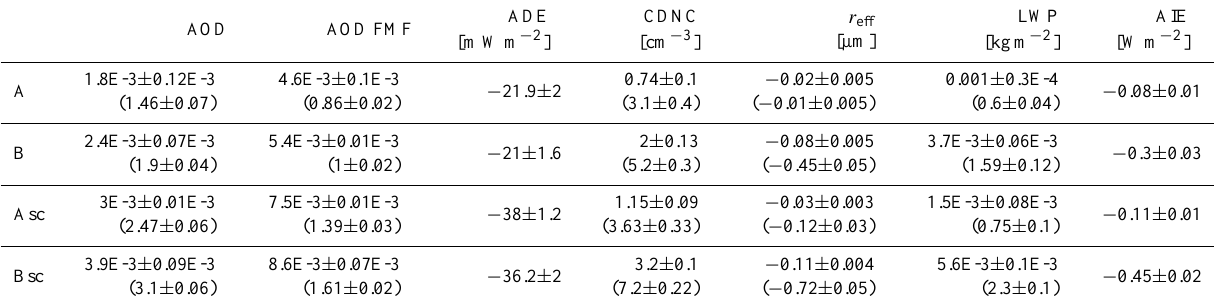
Table 1. Global, five-year averaged changes of aerosol- and cloud properties for the experiments A, B, Asc and Bsc with respect to experiment CTRL, i.e. “experiment – CTRL”, as described in Peters et al. (2012), including the modifications described in the main text. The results for cloud droplet number concentration (CDNC) and cloud droplet effective radius ( r eff ) represent values at cloud top as diagnosed by the model. The values in parantheses represent globally averaged relative changes in % as et al.